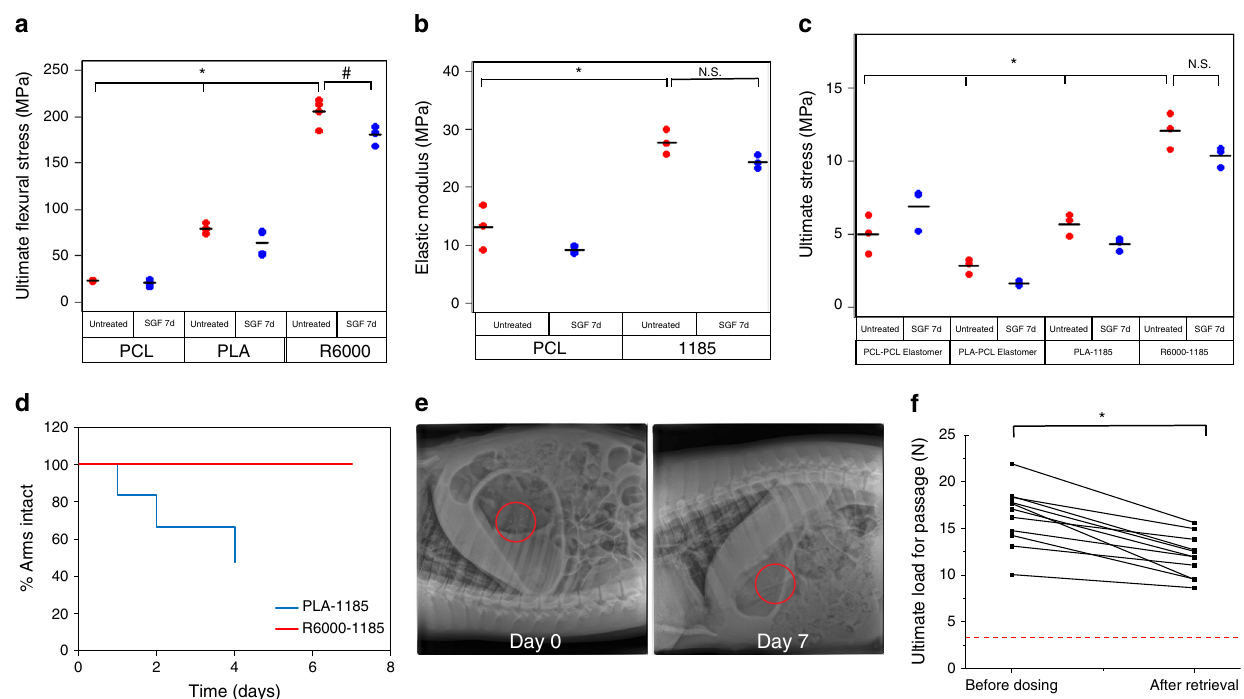
Fig. 2 Mechanical characterization and gastric retention of gastric resident dosage forms. a The ultimate fl exural stresses of various polymers were determined by using a 4-point bending test. Circles indicate individual measurements, and horizontal line indicates mean value. * p < 0.05, one-way ANOVA, post-hoc Bonferroni (comparing R6000 vs. PCL and PLA); # p < 0.05, two-sample t test. b The elastic moduli of candidate central elastomers were determined using tensile testing. Circles indicate individual measurements, and horizontal line indicates mean value. * indicates p < 0.05, N.S. indicates not signi fi cant, two-sample t test c The interface between candidate structural polymers and central elastomers was characterized by tensile testing. Circles indicate individual measurements, and horizontal line indicates mean value., * p < 0.05, one-way ANOVA, post-hoc Bonferroni (comparing R6000-1185 vs. each of the other groups); N.S. indicates not signi fi cant, two-sample t test. d Dosage forms made of Elastollan ® 1185 central elastomer and either PLA or Elastollan ® R6000 arms were administered to pigs. Their integrity was analysed over time. Three dosage forms containing six arms each were tested. e Representative X-rays of dosage forms made of Elastollan ® R6000 arms and Elastollan ® 1185 central elastomer in a pig immediately after deployment and on day 7. f Funnel testing of Elastollan ® R6000-Elastollan ® 1185 dosage forms before dosing in pigs and after retrieval from pig stomach following 7-day residence. *indicates p < 0.05, paired two sample t